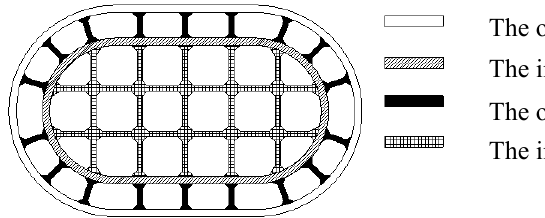
Figure 3. Different area at the bottom of caisson foundation.